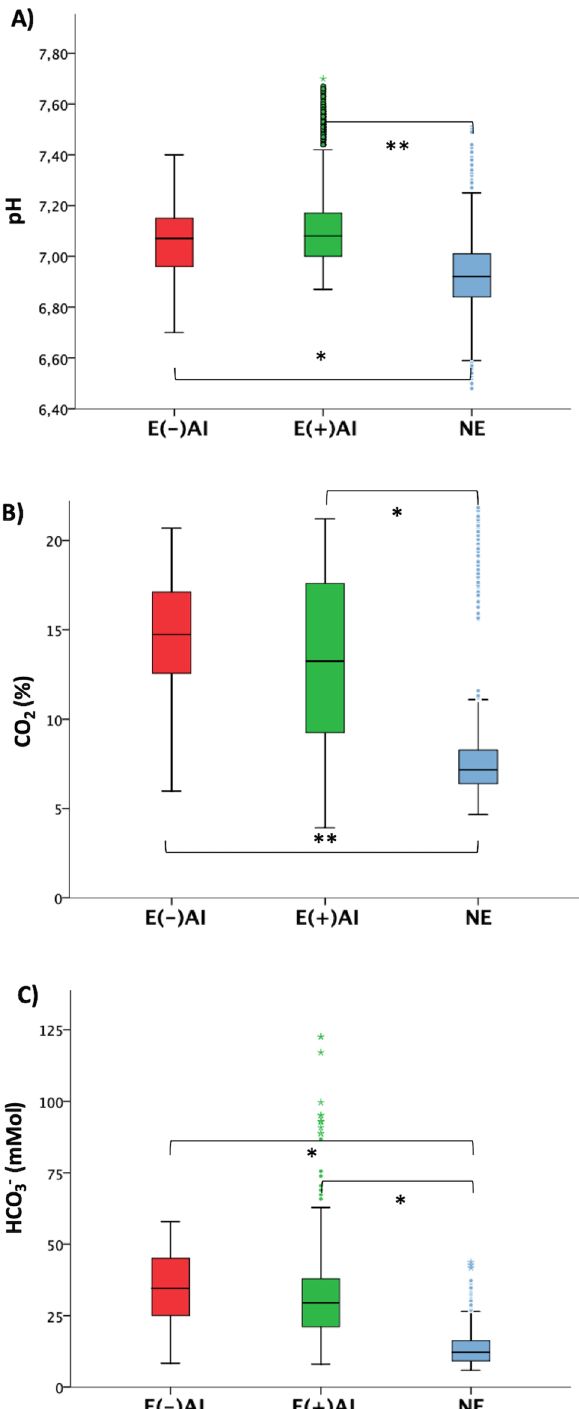
Figure 2. Box-plot describing the uterine levels of pH (A) , CO 2 (%) (B) and HCO 3− (mMol) (C) at the three experimental conditions. In each panel, significant differences between experimental groups are indicated as * P < 0.05 and ** P < 0.001. Small circles and asterisks in the box-plot represent outliers and extreme outliers,